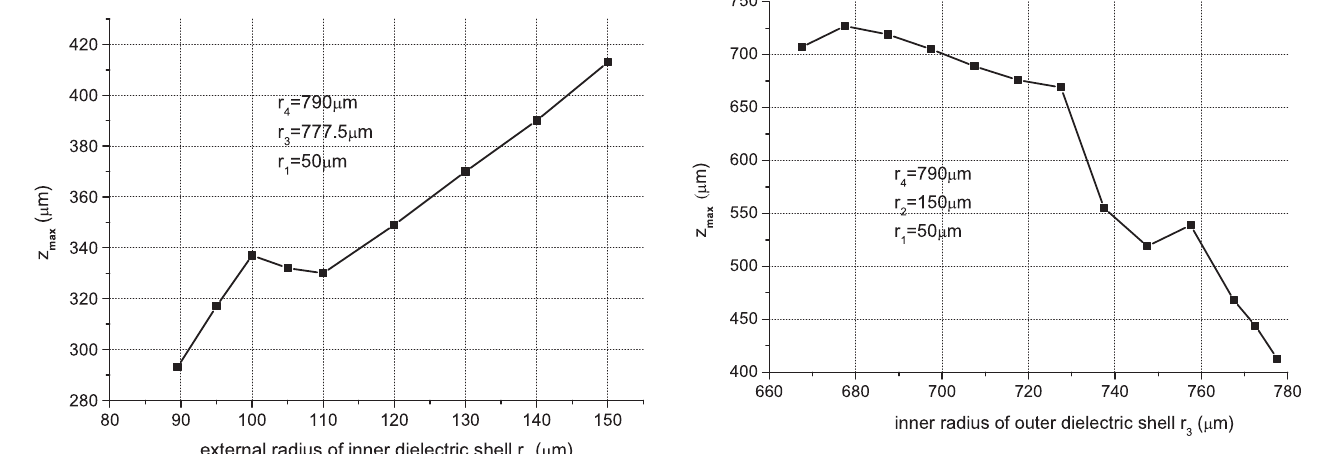
FIG. 10. The location (from drive bunch center) of the first maximum of the accelerating field versus width of the drive channel. The parameters are the same as those in Fig. 9